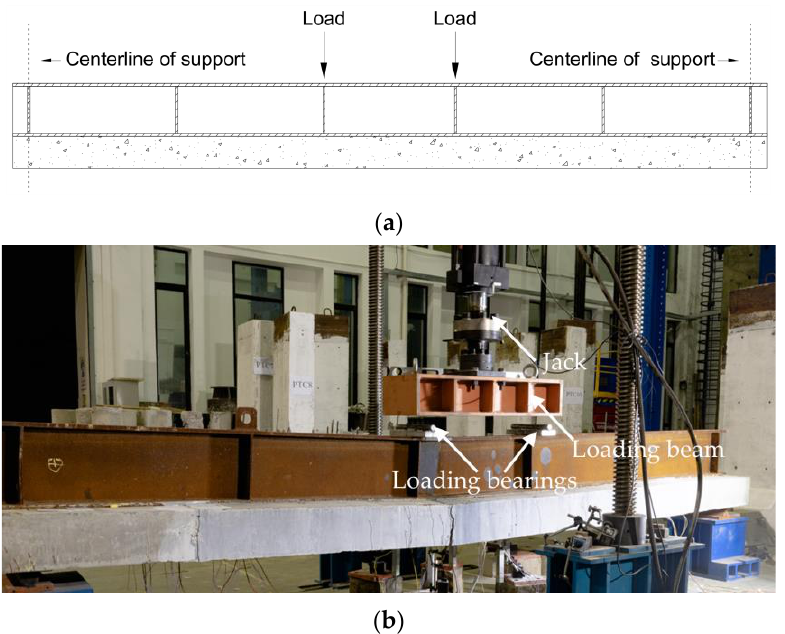
Figure 5. Loading arrangement: ( a ) loading positions along the specimen length; ( b ) loading ar- rangement of the test. ment of the